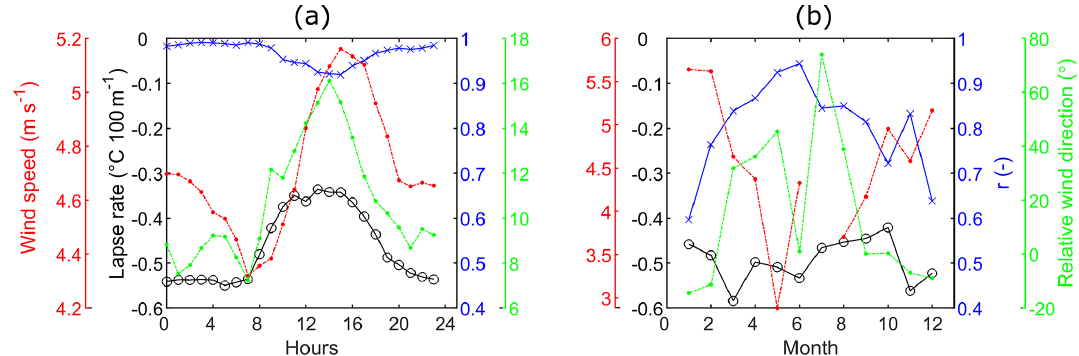
Figure 5. Calculated air temperature lapse rates. The black axis represents the air temperature lapse rate in ◦ C per 100m; the blue axis represents the correlation ( r ) between air temperature and elevation; the red axis represents wind speed; and the green axis the wind direction relative to the main glacier axis (0 ◦ = downglacier, 180 ◦ = upglacier). (a) Diurnal temperature lapse rate from the five HOBO microloggers installed on ablation stakes from May to August 2015 (see Fig. 1). (b) Seasonal variation in the lapse rate derived from the permanent weather stations (see Fig. 1). Wind speeds and directions on both panels are from the glacier AWS.